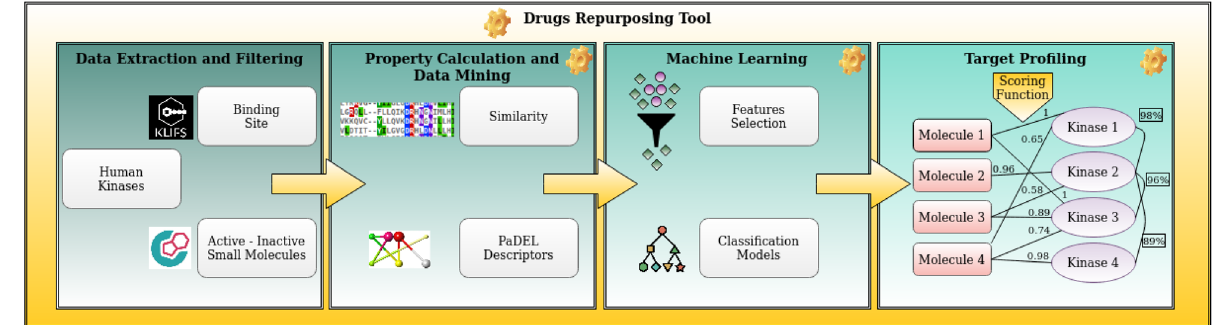
Figure 1. Workflow description of KUALA approach. The entire workflow is composed of four principal steps: (1) data extraction and filtering; (2) property calculation and data mining; (3) machine learning; and (4) target profiling with scoring function estimation for each predicted kinase-ligand